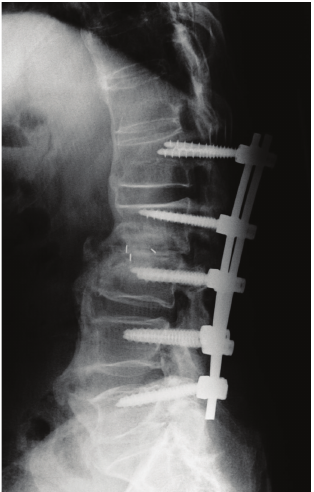
Figure 4: Lateral plain X-ray image obtained 10 weeks after the first surgery, showing loosening and back-out of the pedicle screw at L1-